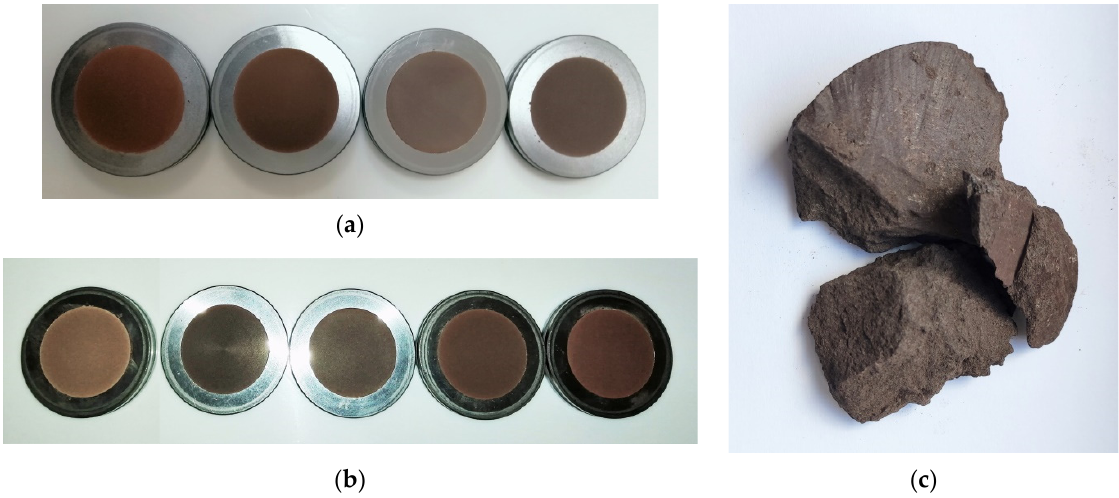
Figure 3. The tuff samples prepared for the XRF analysis: Radoshivka–1 well ( a ) and Radoshivka–2 well ( b ); an exemplary sample of a raw rock ( c ).